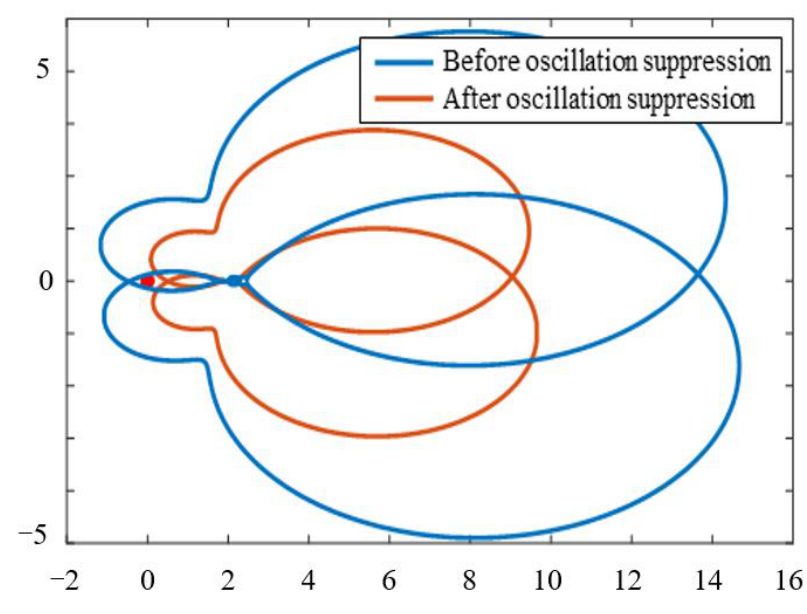
Figure 22. Nyquist curve before and after low-frequency resonance suppression.